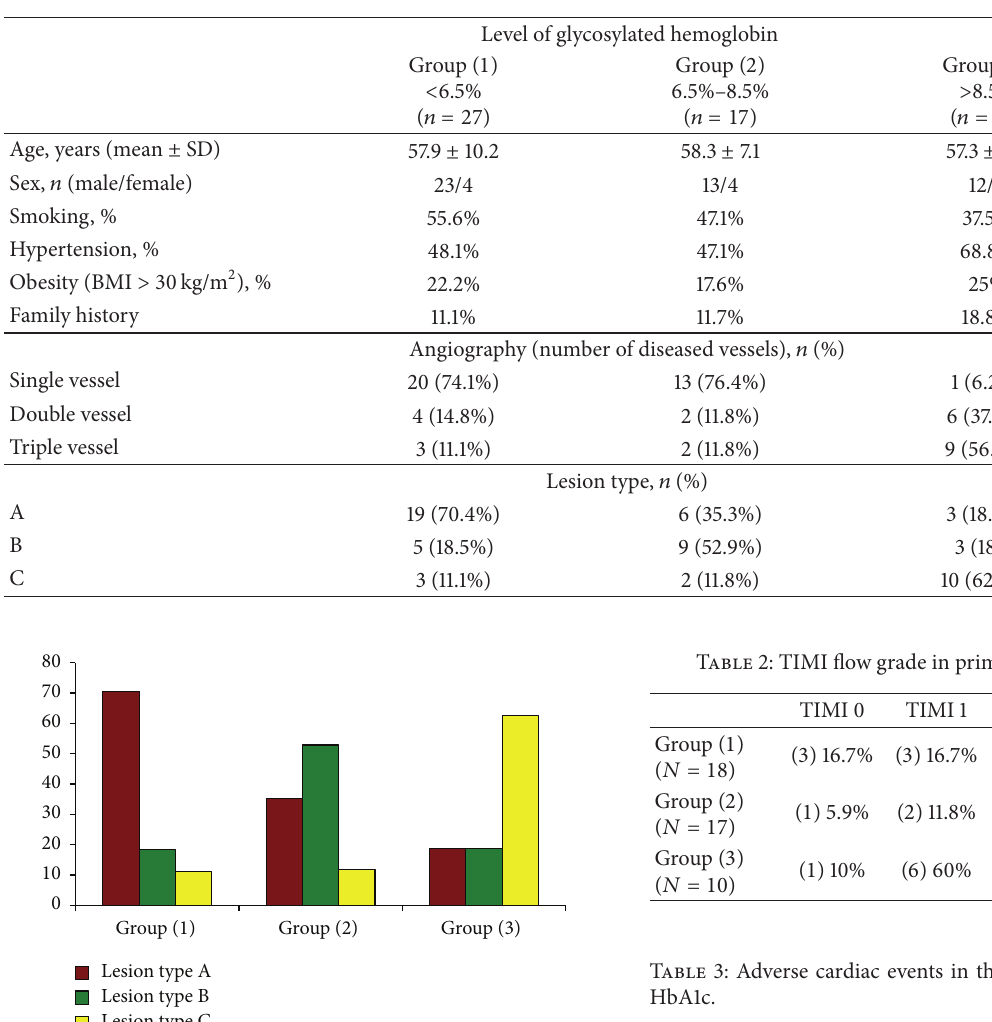
Table 1: Baseline clinical and angiographic data of patients according to HbA1c.